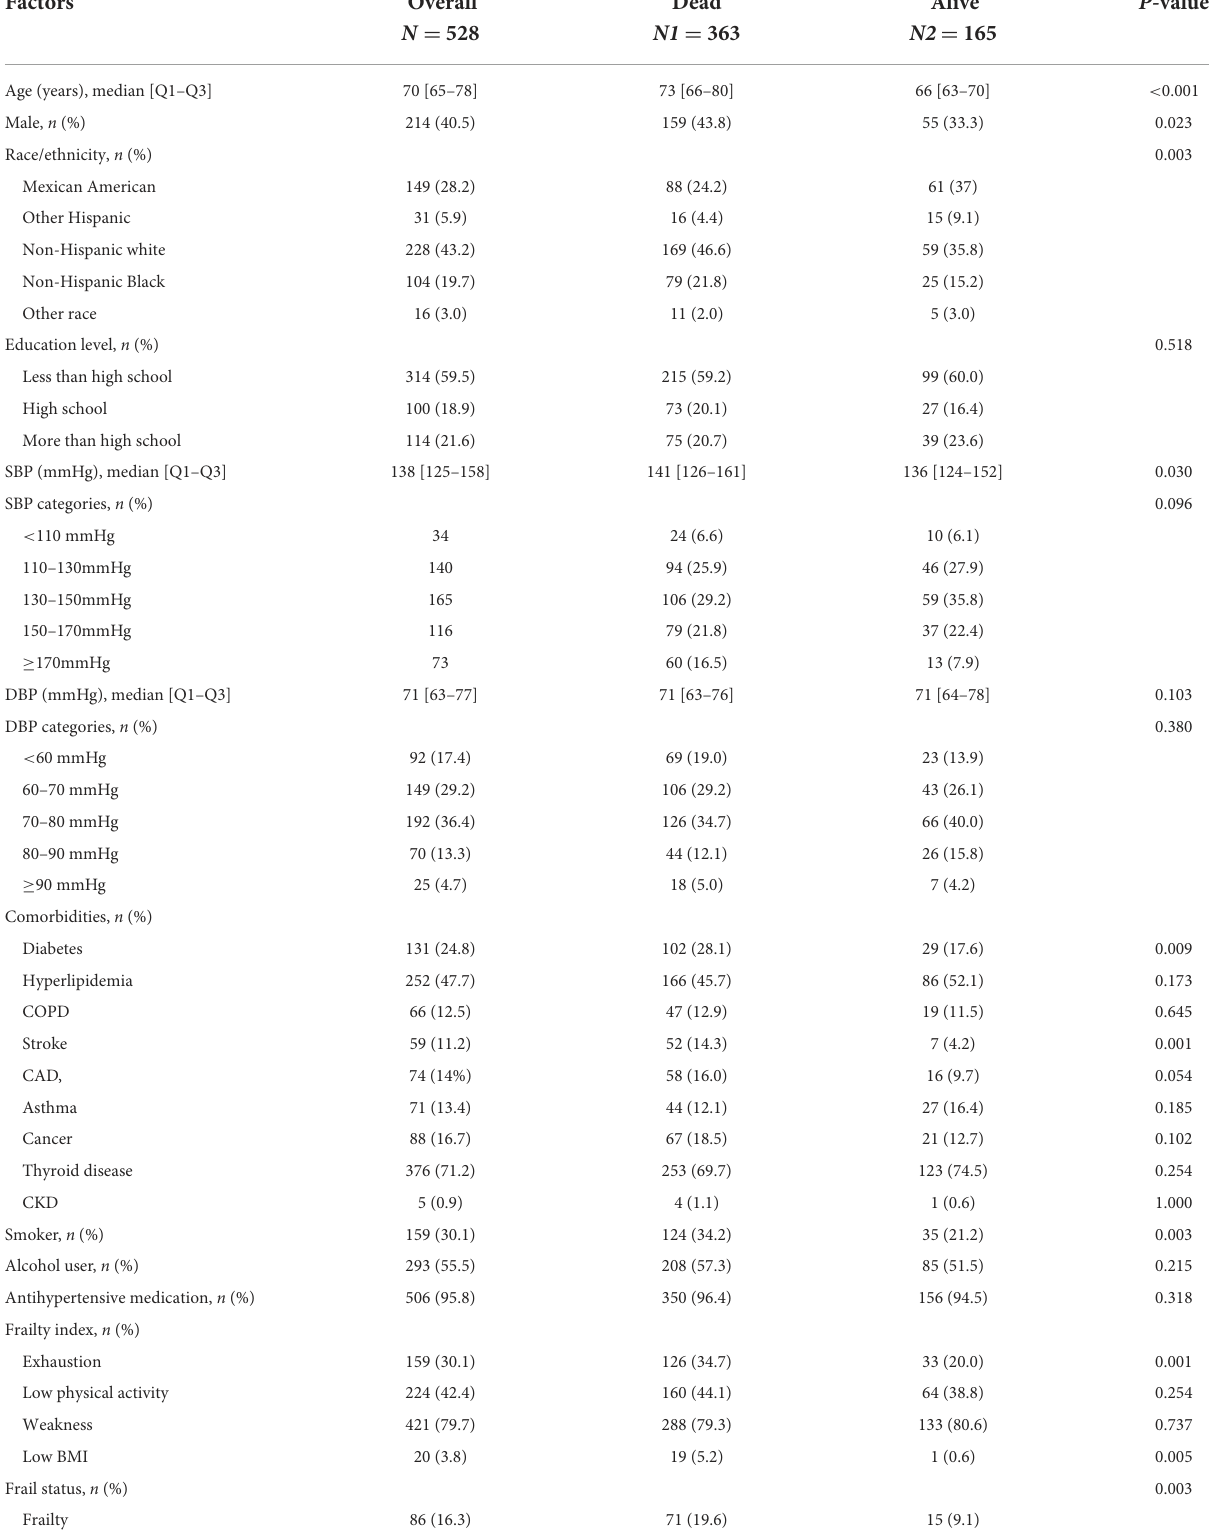
TABLE 1 Baseline characteristics of the analyzed